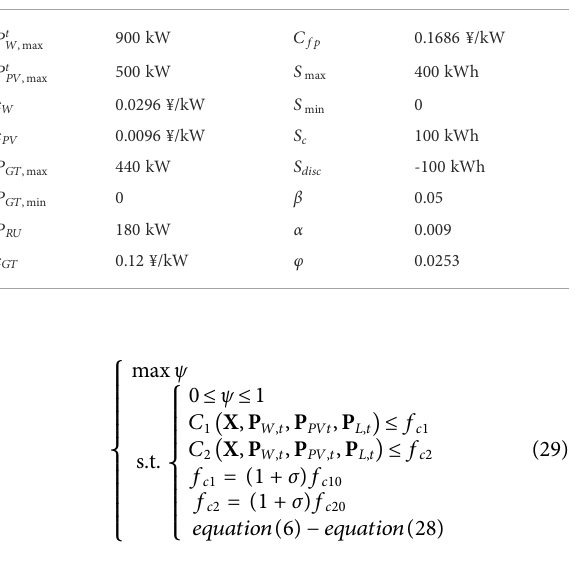
TABLE 1 Relevant